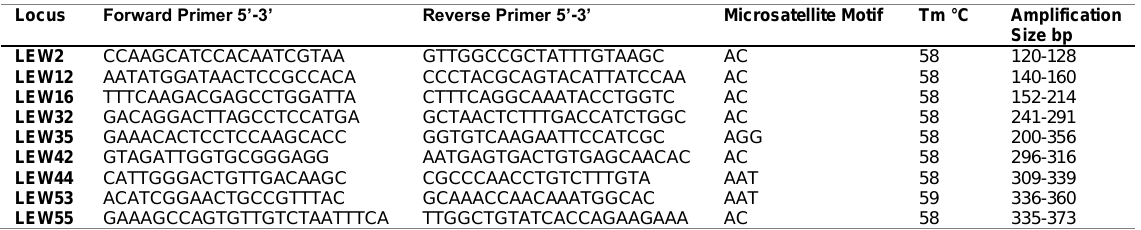
Table 2: Primers and characteristics of the nine microsatellite markers